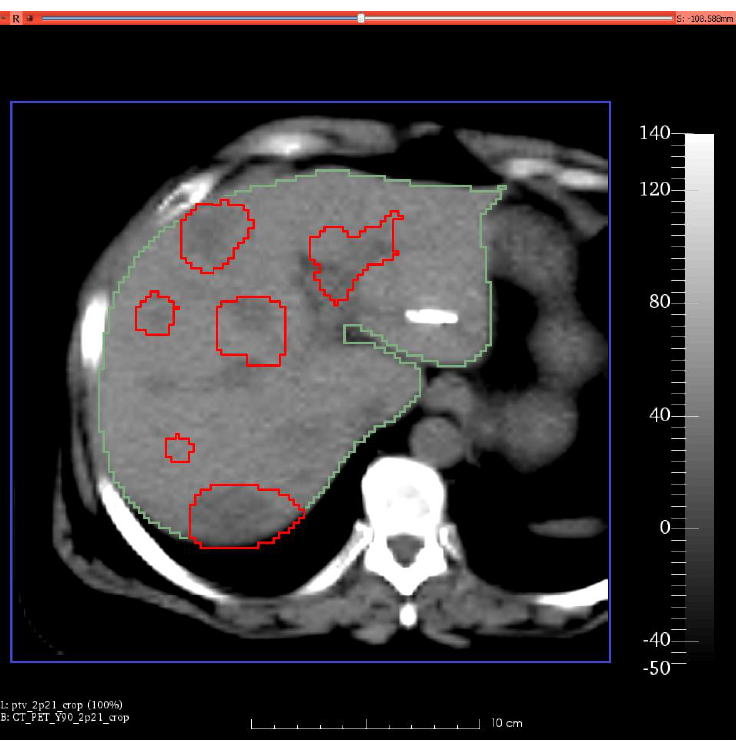
Figure 3. Example of a patient ’s liver ROI in a single CT slice. The red and green lines represent the PTV and the liver masks, respectively. The mask of the dose computation box is represented by the blue square.